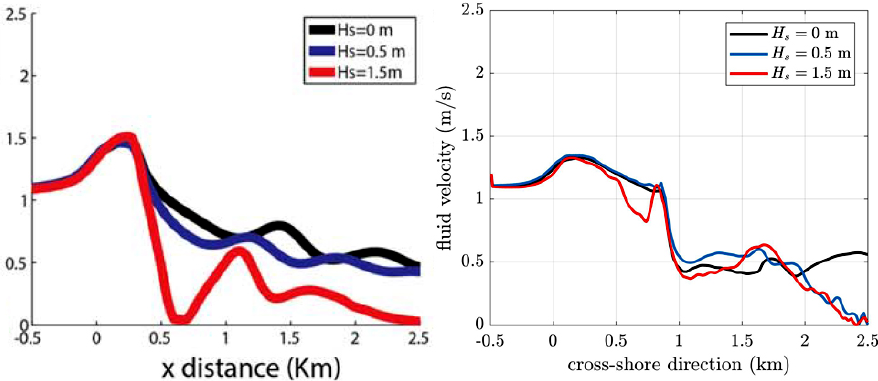
Figure 5. Comparison of velocity along the mouth and shoal central axis as a function of the significant wave height of the opposing waves. ( Left ) velocity along the middle axis of the domain for the tests performed by OL14 (image reprinted with permission). ( Right ) velocity along the middle axis of the domain obtained using our NSWE solver and averaged over 10 wave